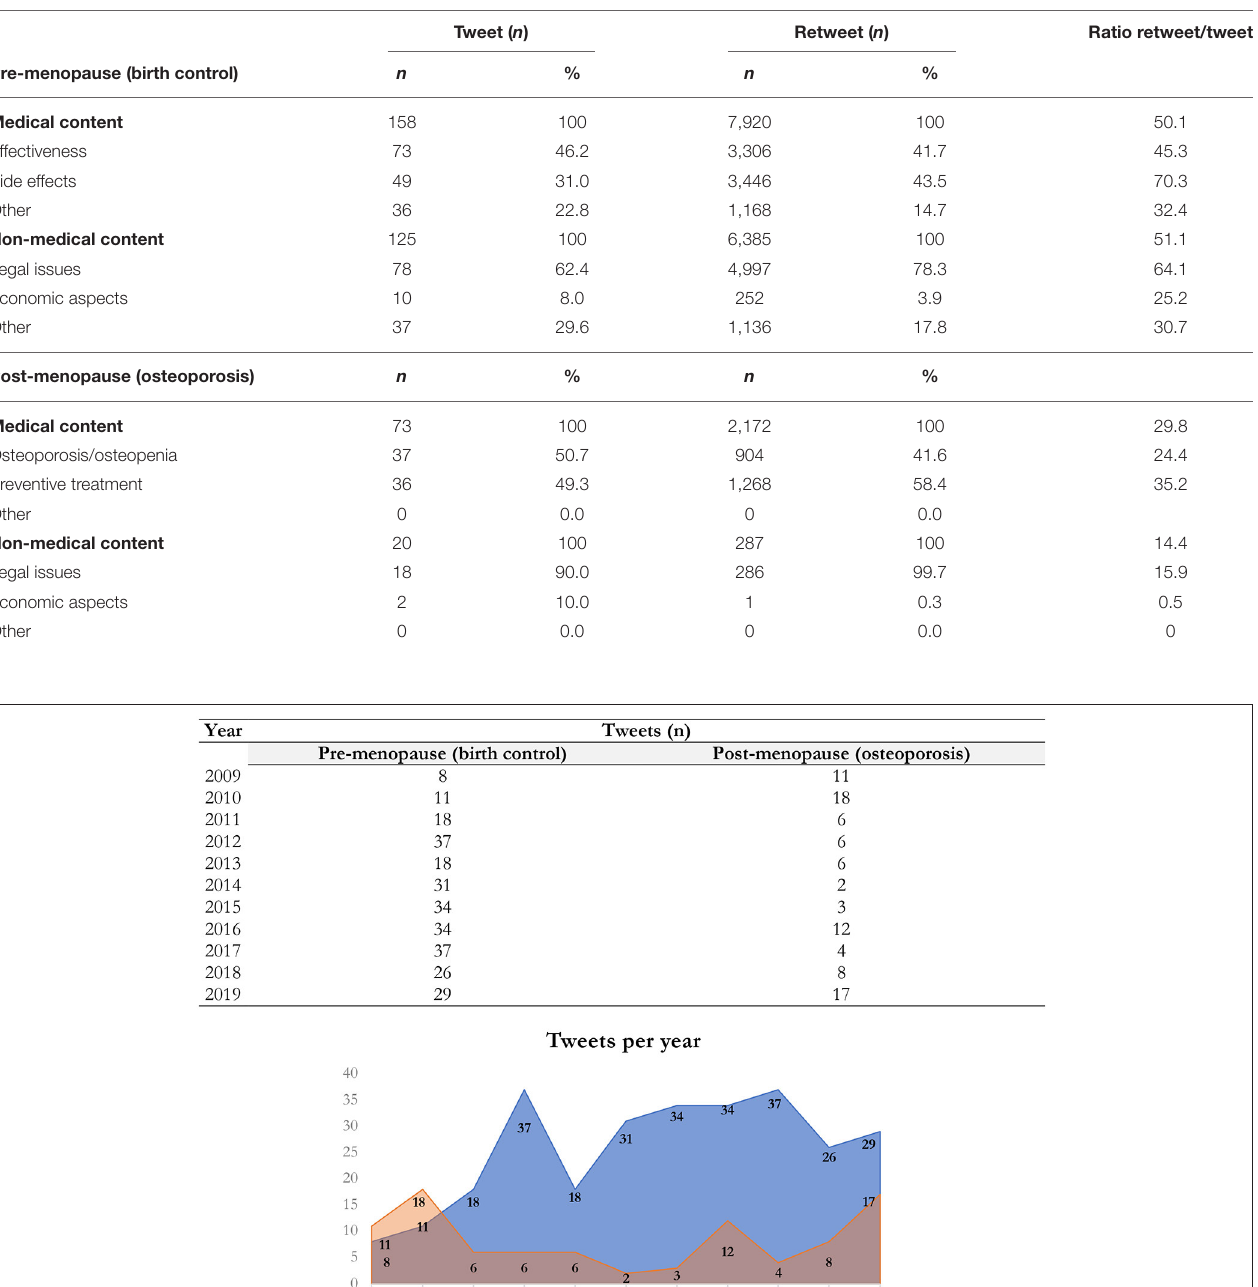
TABLE 5 | Retweet/tweet ratios in pre-menopause (birth control) and post-menopause (osteoporosis).